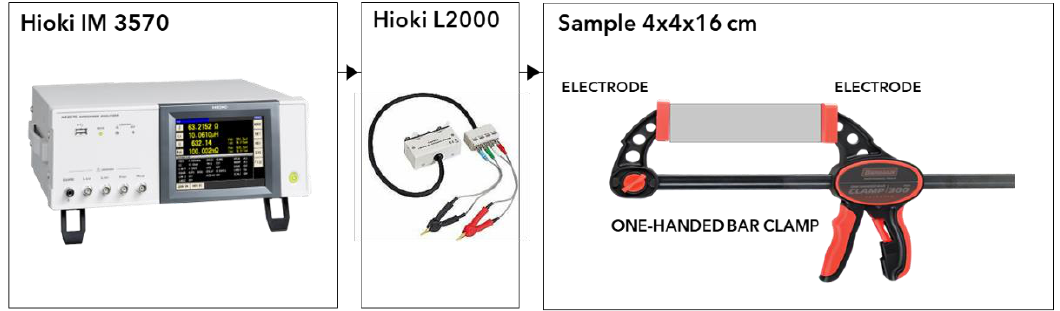
Figure 1. Electrical Impedance Spectroscopy testing configuration.